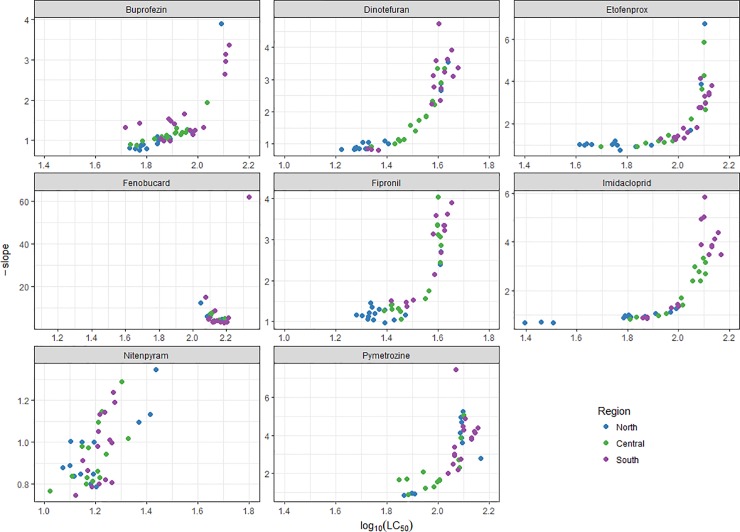
Correlation of LC50 and slope of BPH populations from three regions of Vietnam.